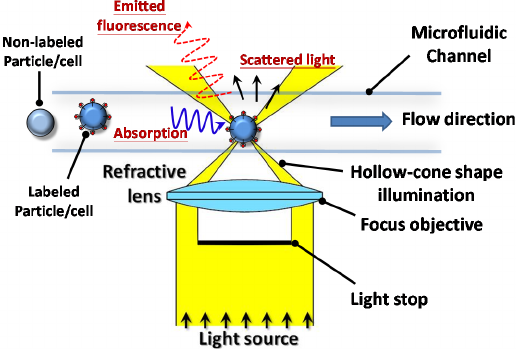
Figure 1. Working principle of the proposed diascopic illumination technique in multispectral cytometry analyses.